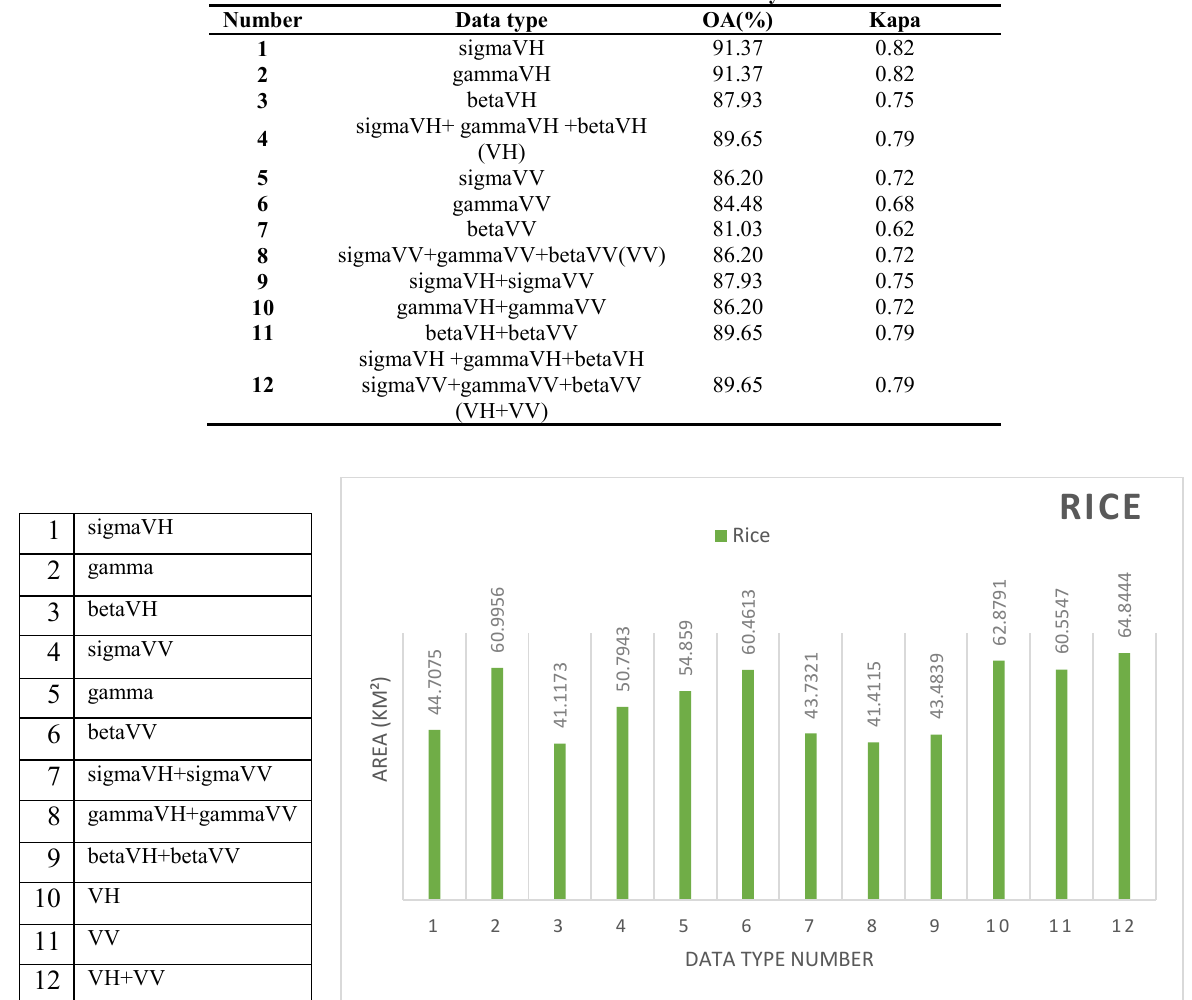
Table 2. The result of the classification accuracy assessment